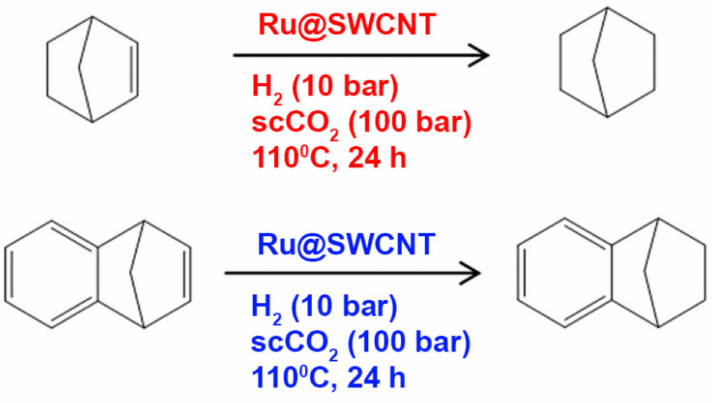
Figure 6. Schemes of hydrogenation reactions of norbornene and benzonorbornadiene in the presence of RuNPs encapsulated inside SWCNTs. Redrawn from